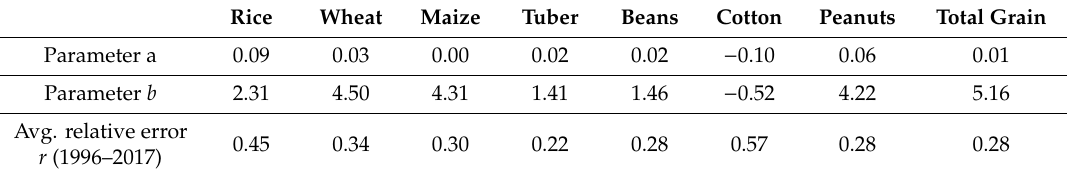
Table 8. Parameters setup on crops yield prediction with the GM (1,1)